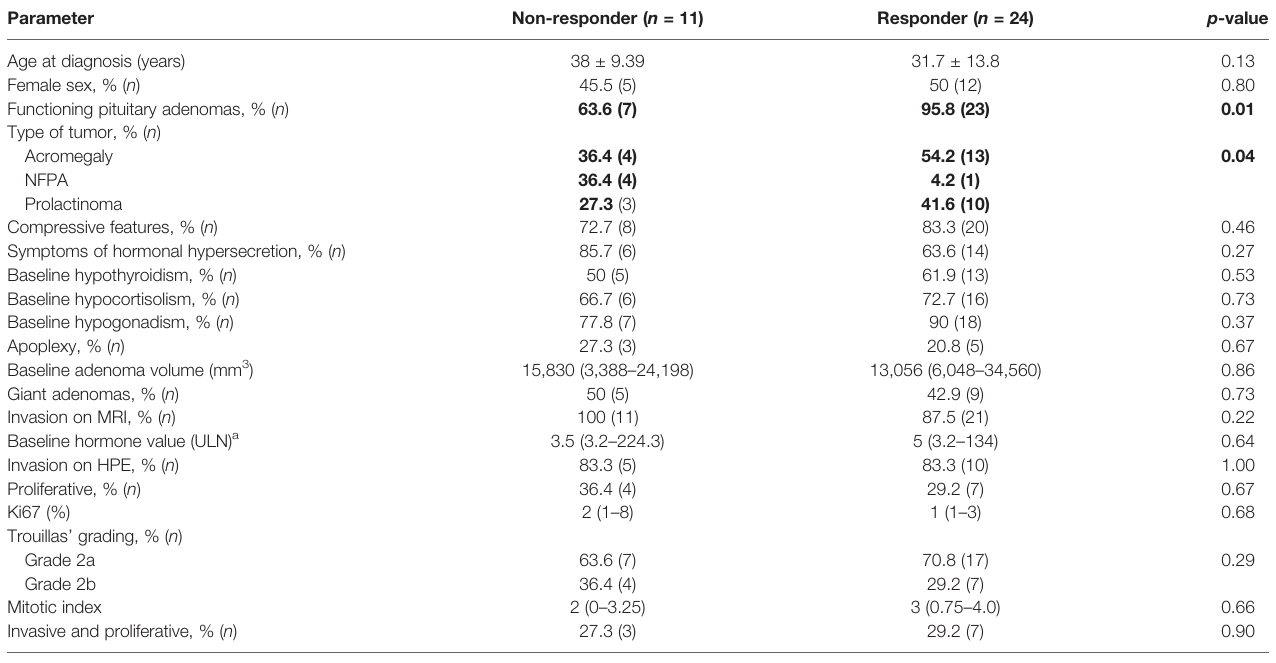
TABLE 1 | Baseline demographic and clinical, radiological, and histopathological parameters in the cohort of patients managed with temozolomide. Parameter